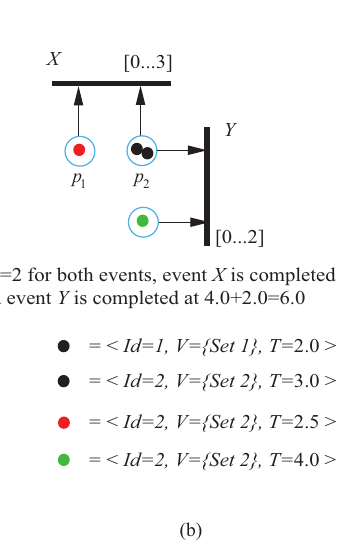
Figure 5. ( a ) Two or more tokens in different places activate a transition, ( b ) two or more transitions are